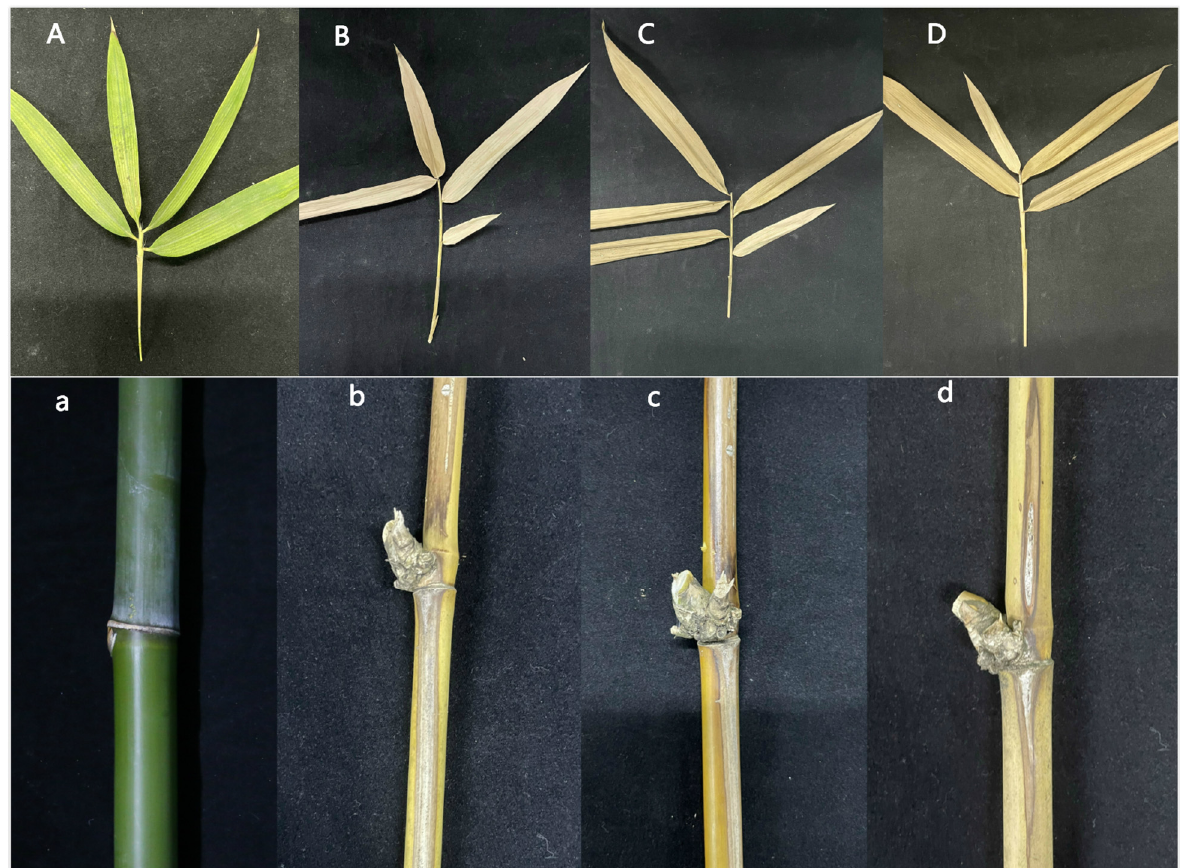
Figure 16. Symptoms of branches and leaves of plants infected with sterile water, Ctf1 β 1 complemented strain, Ctf1 β 2 complemented strain and wild-type strains after 25 days. Note: ( A ) and ( a ) are the symptoms of B. pervariabilis × D. grandis leaves and branches inoculated with sterile water for 25 days, respectively. ( B ) and ( b ) are the symptoms of B. pervariabilis × D. grandis l eaves and branches inoculated with Ctf1 β 1 complemented strain for 25 days, respectively. ( C ) and ( c ) are the symptoms of B. pervariabilis × D. grandis l eaves and branches inoculated with Ctf1 β 2 complemented strain for 25 days, respectively. ( D ) and ( d ) are the symptoms of B. pervariabilis × D. grandis l eaves and branches inoculated with wild type strain for 25 days, respectively.